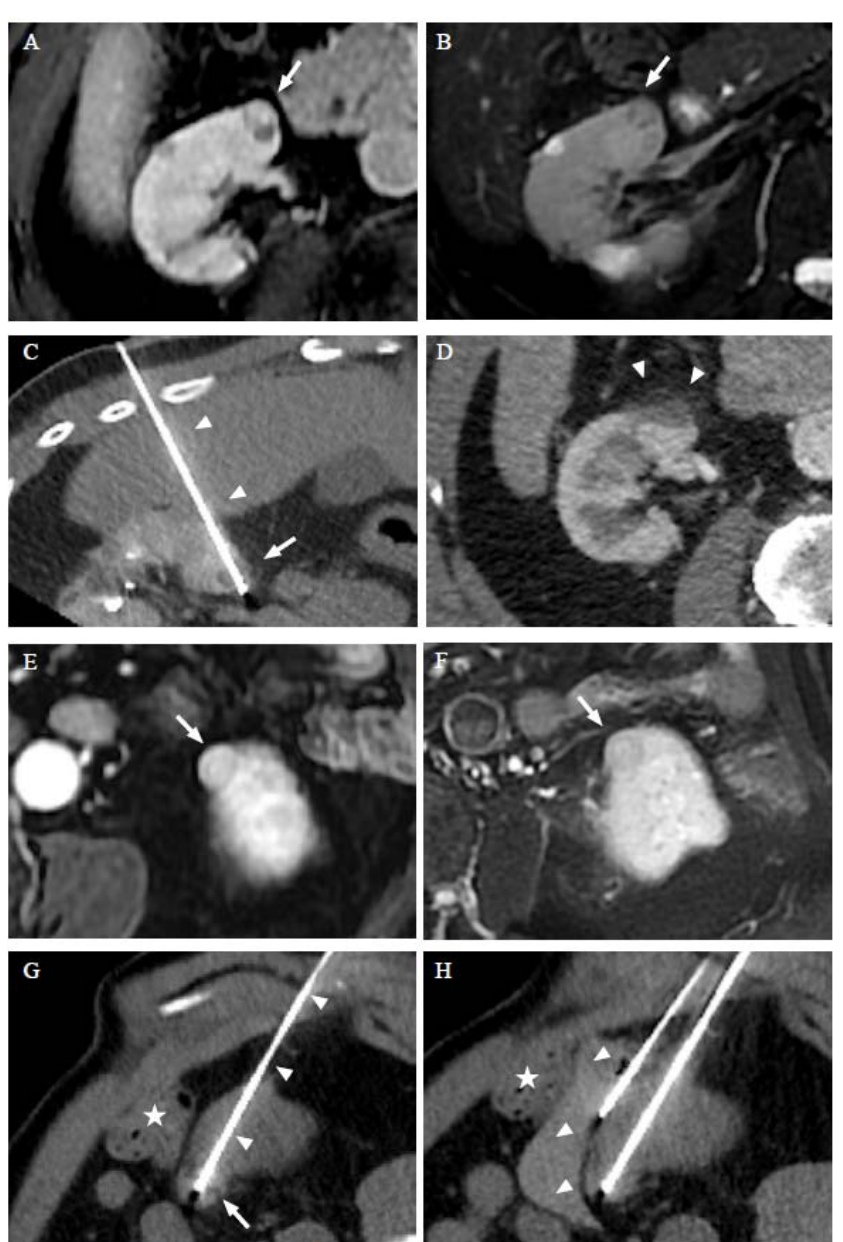
Figure 1. RFA of a 68-year-old man with Birt–Hogg–Dubé syndrome who had a history of partial nephrectomy and presents two ccRCCs treated in two separate sessions. Dynamic axial T1w se- quences with fat suppression after gadolinium injection ( A ) and axial T2w image with fat saturation ( B ) show the first ccRCC (arrow) treated. Computed tomography (CT) images in the axial plane obtained during the RFA show the transhepatic probe (arrowheads) into the lesion (arrow) ( C ). CT images in the axial plane on the follow-up 6 months later show a RFA scar (arrow) ( D ). Dynamic axial T1w sequences with fat suppression after gadolinium injection ( E ) and axial T2w image with fant saturation ( F ) show the second ccRCC (arrow) developed in the left kidney 26 months after the initial RFA session. CT images in the axial plane obtained during the 2nd session of RFA show the RFA probe (arrowheads) into two of the lesions ( G ), and hydrodissection with 60 cc of serum glu- cose 30% was performed to protect the colon (star) ( H ). The patient was alive with no local progres- sion or distant metastasis 33 months after the initial thermal ablation.